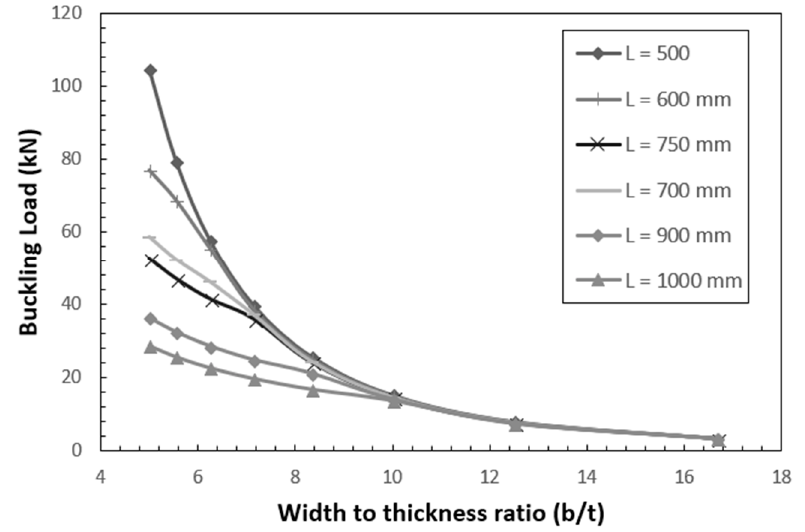
Figure 10. Effect of width-to-thickness ratio on buckling load.